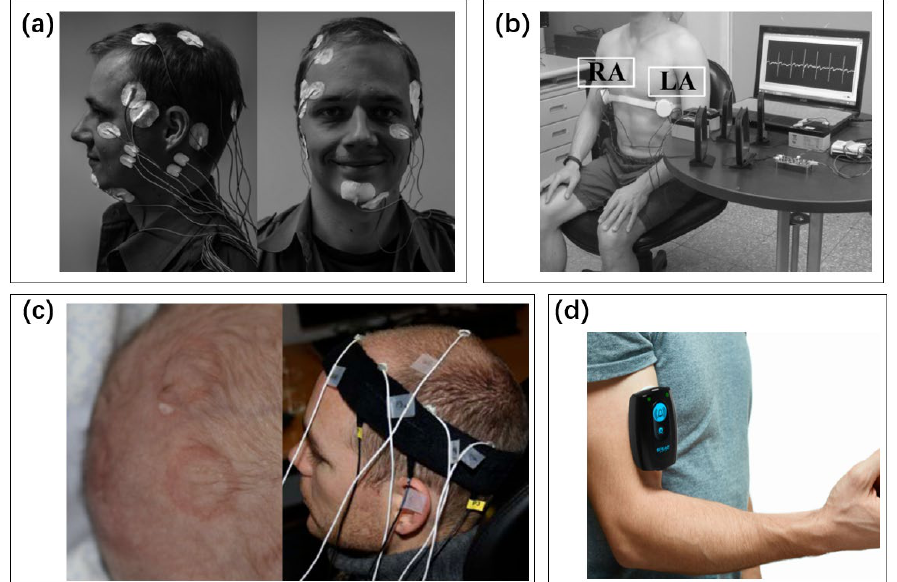
Figure 5. ( a ) Six EEG electrodes, two EOG electrodes, two chin EMG electrodes, two mastoidal reference electrodes, and bipolar EMG electrodes placed on the masseter [56]. Reproduced with permission, Copyright 2017 European Sleep Research Society. ( b ) Wearing of ECG [64]. RA and LA electrode pairs are placed between 5th and 6th ribs to avoid muscle movement interference. Repro-